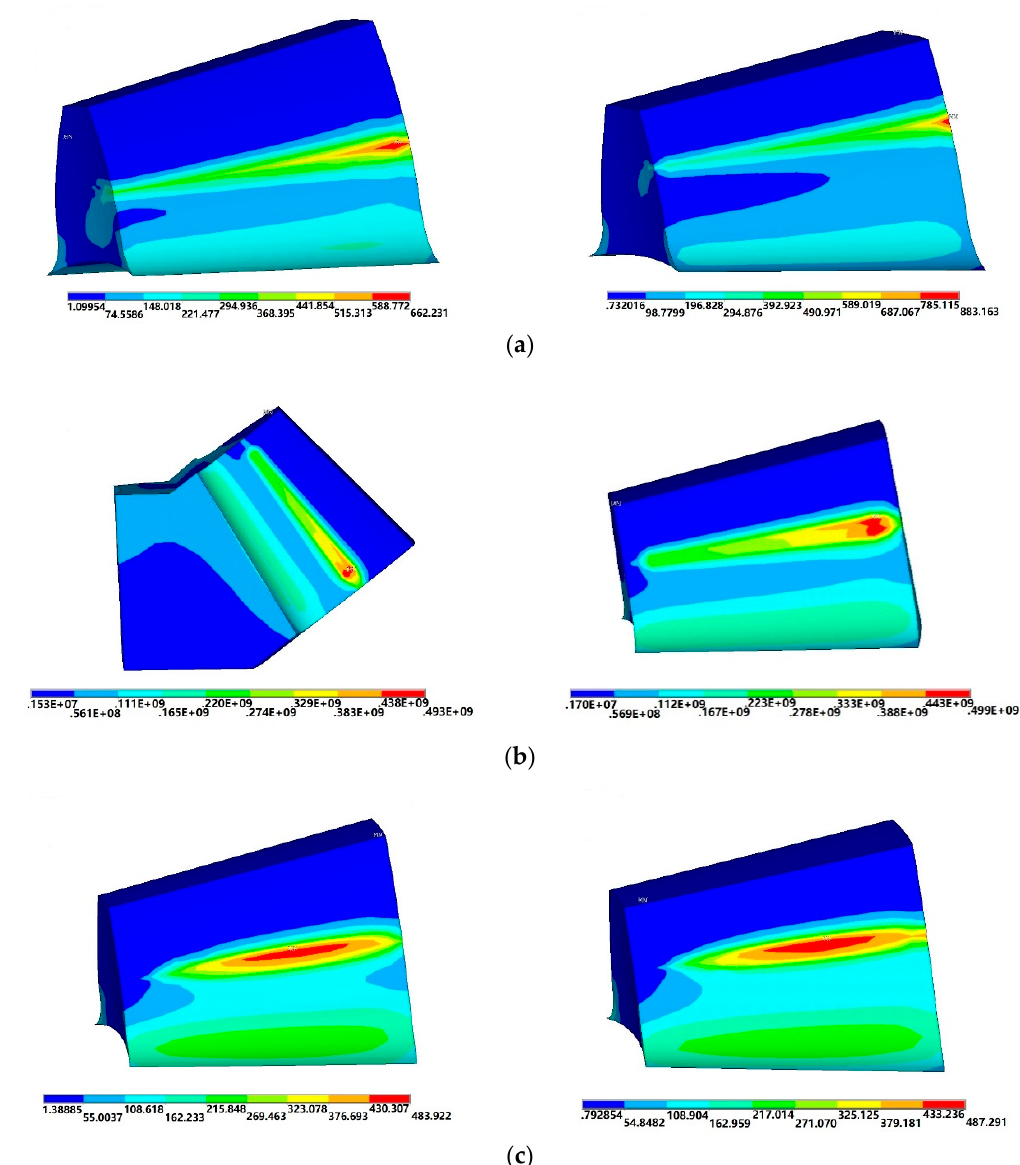
Figure 11. Distribution of contact stress on tooth surface for pinion (left) and the gear (right) when (cid:1986) P = 0.1. ( a ) No modification, ( b ) Case4 and ( c ) Case1.